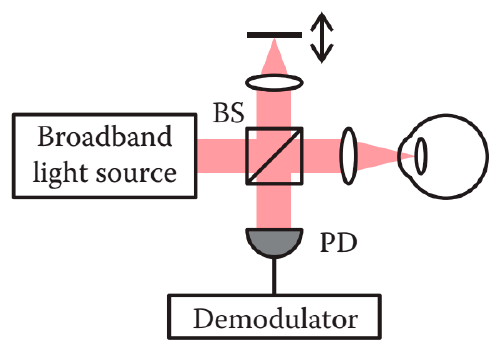
Figure 15. Schematic diagram of a time domain-optical coherence tomography (TD-OCT) system [85]. PD: Photodetector; BS: Beam splitter.